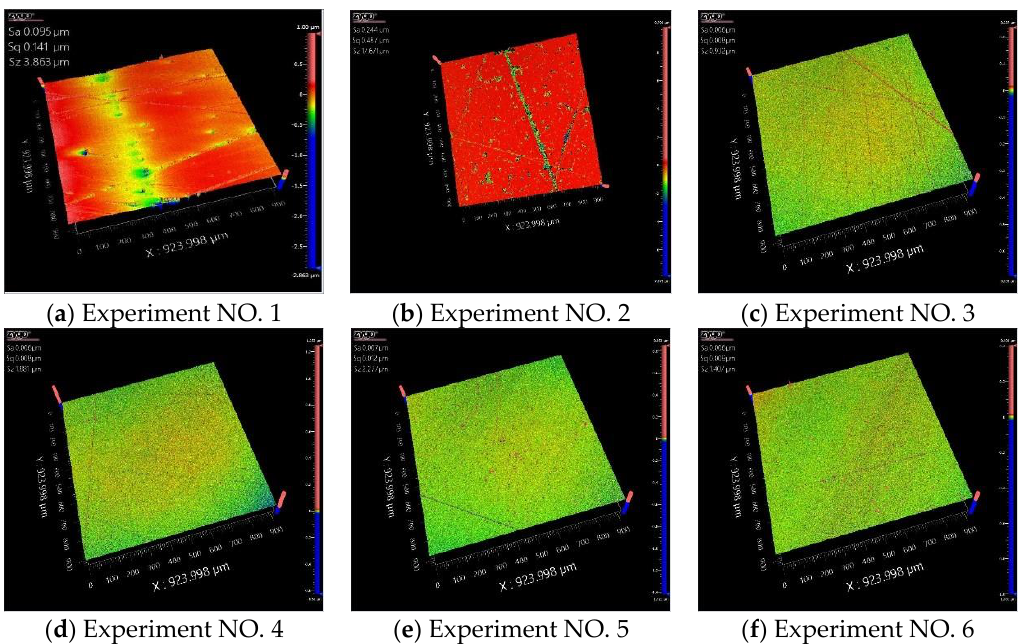
Figure 35. Scratch morphology of the workpiece